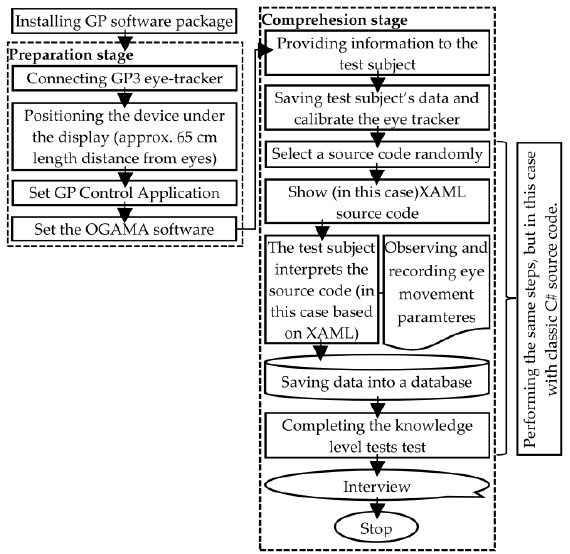
Figure 2. A schematic diagram of the equipment setup.